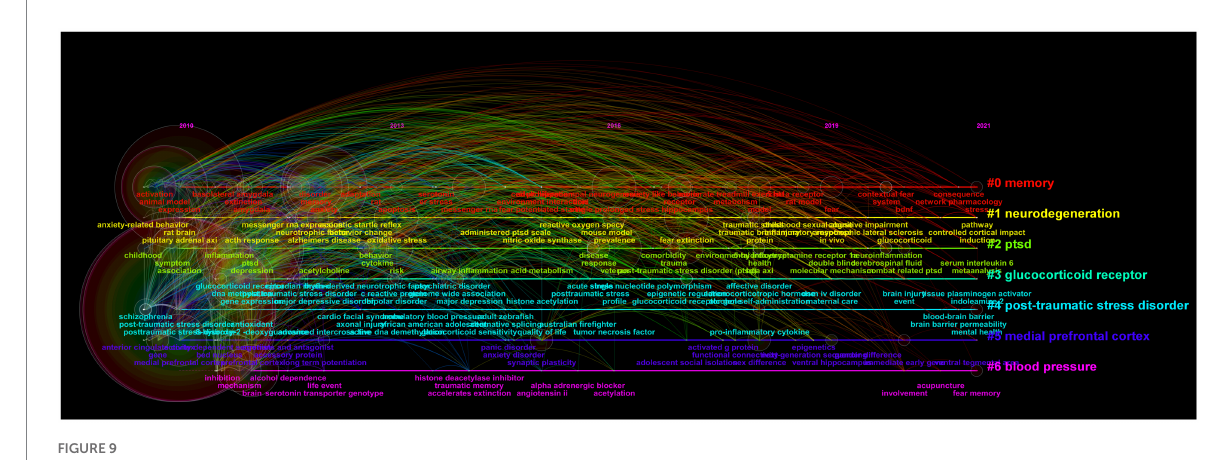
FIGURE 9 Time diagram of keyword clustering analysis of biomarker.